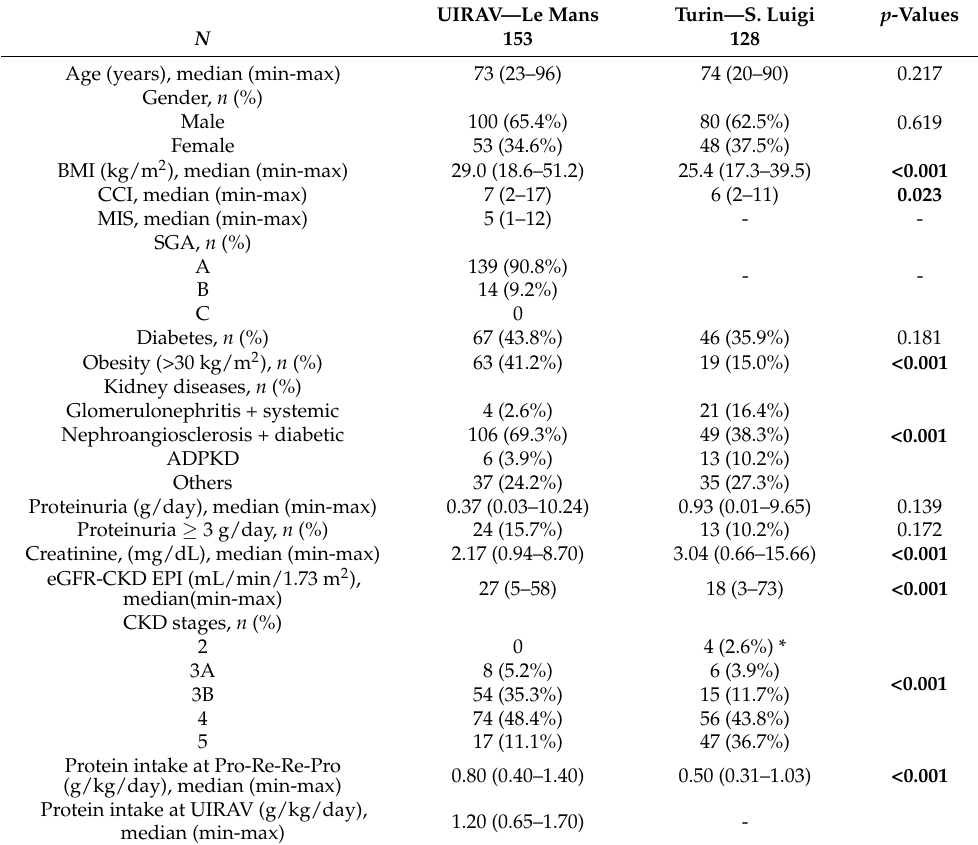
Table 1. Baseline characteristics of the population, in the UIRAV unit, and in the Turin unit. UIRAV—Le